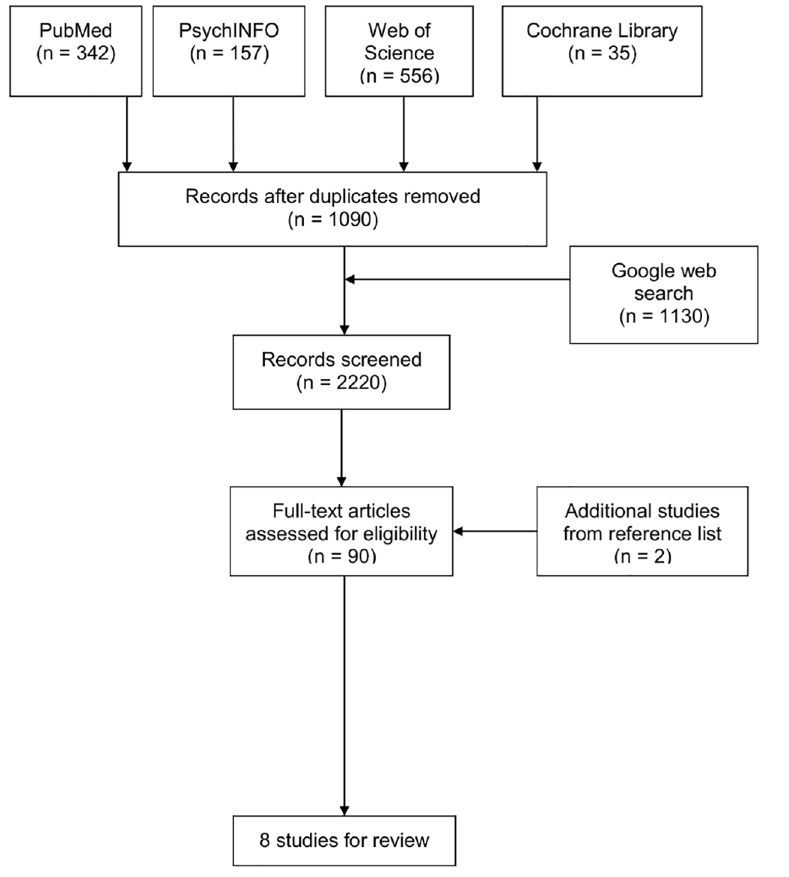
Fig 1. The different phases of the systematic review. 1 HCP = Health Care